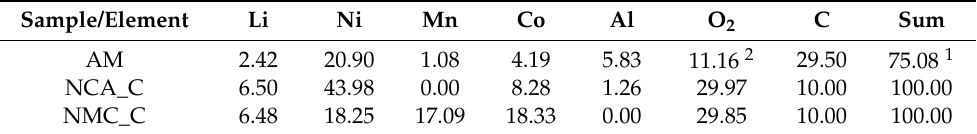
Table 2. Chemical composition of the input mixtures for the InduMelt experiments. (w/%). Sample/Element